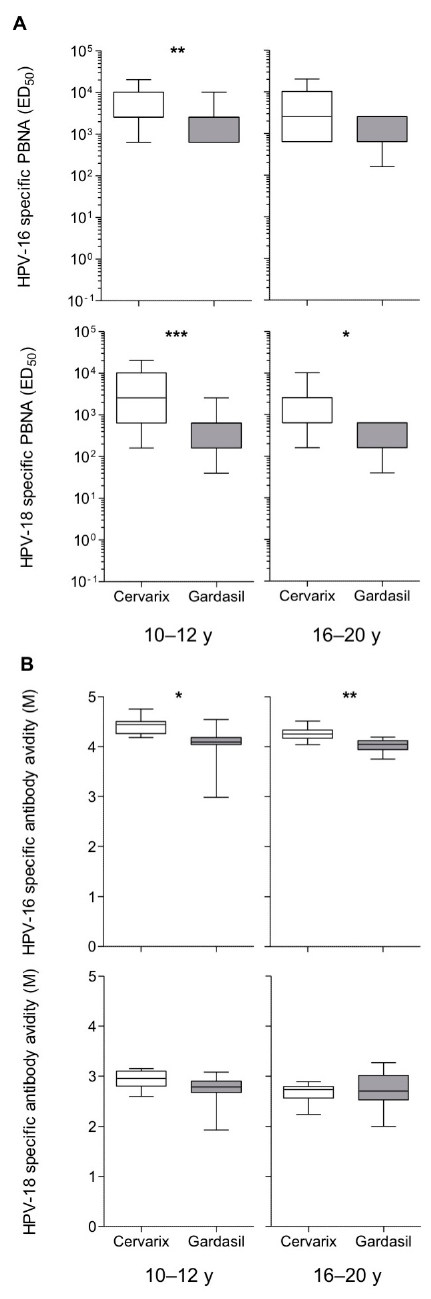
Figure 3. HPV-16 and HPV-18 specific nAbs and IgG avidity. ( A ) HPV-16 and HPV-18 specific nAbs measured by the PBNA, in ELISA responders, reported as ED 50 and shown as box and whiskers plots; for HPV-16 10–12 y, n = 62 (Cervarix) and n = 27 (Gardasil); for HPV-16 16–20 y, n = 31 (Cervarix) and n = 16 (Gardasil); for HPV-18 10–12 y, n = 58 (Cervarix) and n = 23 (Gardasil); for HPV-18 16–20 y, n = 32 (Cervarix) and n = 10 (Gardasil). ( B ) Avidity of HPV-16 and HPV-18 specific IgG, measured in a subgroup of ELISA responders, reported as molarity (M) and shown as box and whiskers plots; for HPV-16 10–12 y, n = 10 (Cervarix) and n = 7 (Gardasil); for HPV-16 16–20 y, n = 10 (Cervarix) and n = 8 (Gardasil); for HPV-18 10–12 y, n = 10 (Cervarix); and, n = 7 (Gardasil); for HPV-18 16–20 y, n = 10 (Cervarix) and n = 8 (Gardasil). Statistical comparisons were made while using Mann–Whitney test, * P < 0.05, ** P < 0.01, *** P < 0.001.